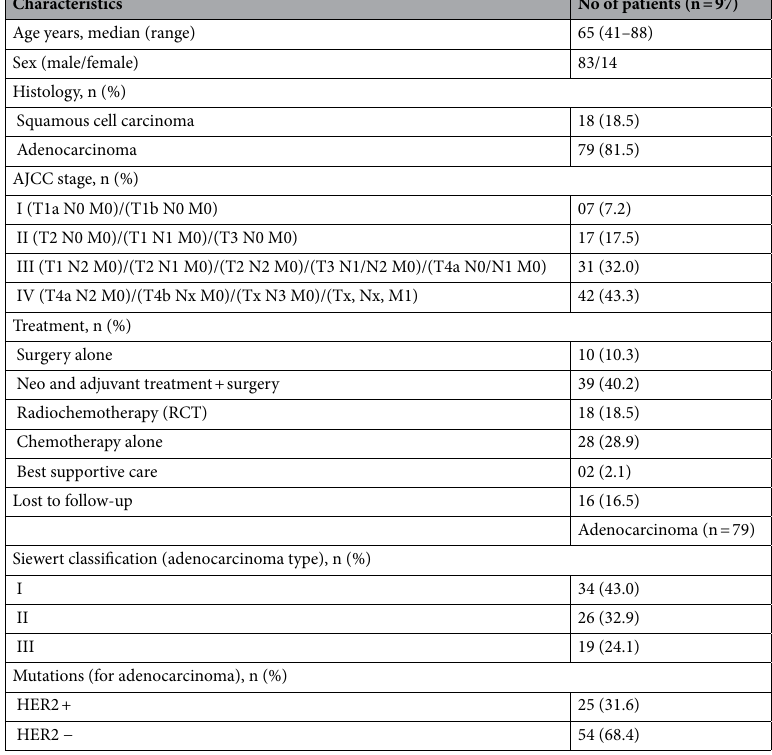
Table 1. Characteristics of patients at baseline. AJCC American Joint Committee of Cancer, HER2 human epidermal growth factor receptor 2.